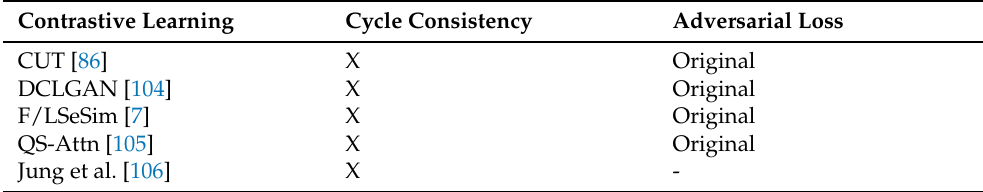
Table 10. Comparison between papers in the Contrastive Learning category (Section 9.2). The comparison is on the use of the cycle consistency and the type of adversarial loss. “V” and “X” means that the method use the technique in the columns is “used” and “not used” respectively. “-” indicates that the corresponding information has not been